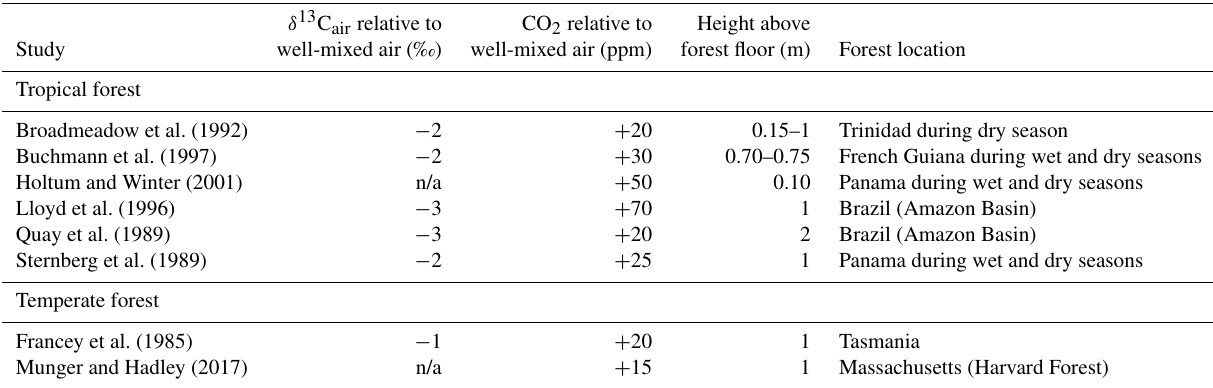
Table 2. Deviations in the δ 13 C and concentration of CO 2 close to a forest floor relative to well-mixed air above the canopy. All measurements were made close to